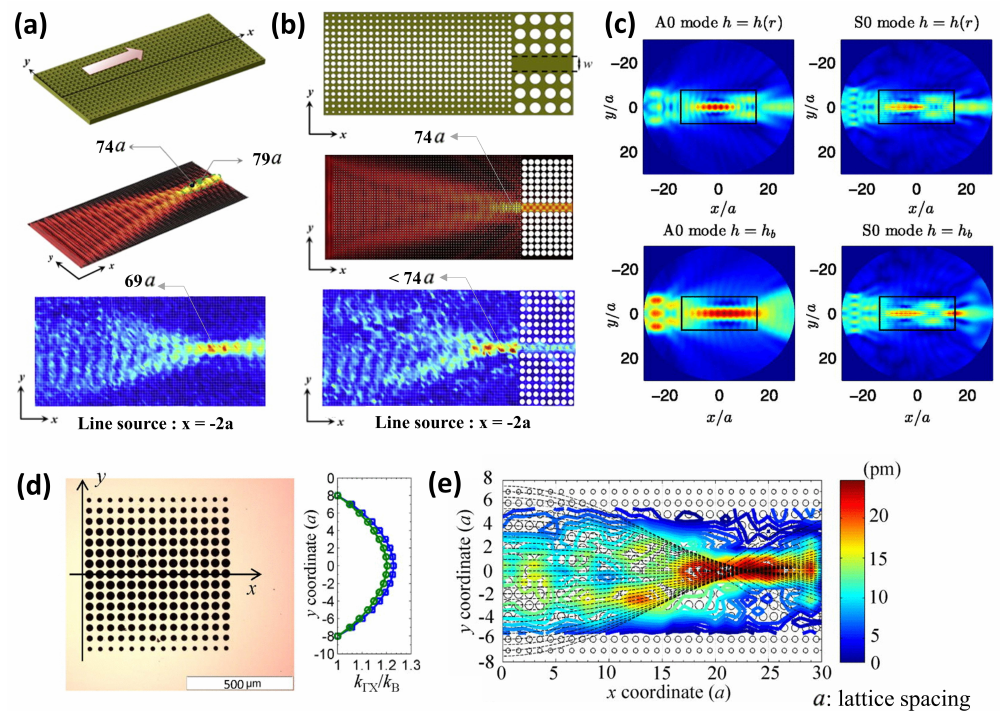
Figure 3. ( a ) GRIN PC plate on an AT-cut quartz plate (top). Arrow: wave propagation direction ( x axis). The simulation of focusing of the lowest A0 mode in the designed GRIN PC lens (center). The measured amplitude distributions of the GRIN PC plate lens at 10 MHz (bottom); ( b ) Same as ( a ) but a linear waveguide is added; ( c ) Upper side: Normalized field distribution for a A0-polarized (left) and a S0-polarized (right) plane waves where the thickness of the plate is designed to focus the two Lamb modes simultaneously. Lower side: same as the upper side but the thickness of the plate is constant; ( d ) GRIN PC on a silicon plate with a thickness 500 µ m (left) with simulated (blue squares) and experimental (green circles) values of the effective refractive index (right); ( e ) Experimental maximum of out-of-plane displacement in GRIN PC lens. Dashed black lines: ray trajectories. ( a , b ) adapted from [75]. ( c ) adapted from [76]. ( d , e ) adapted from